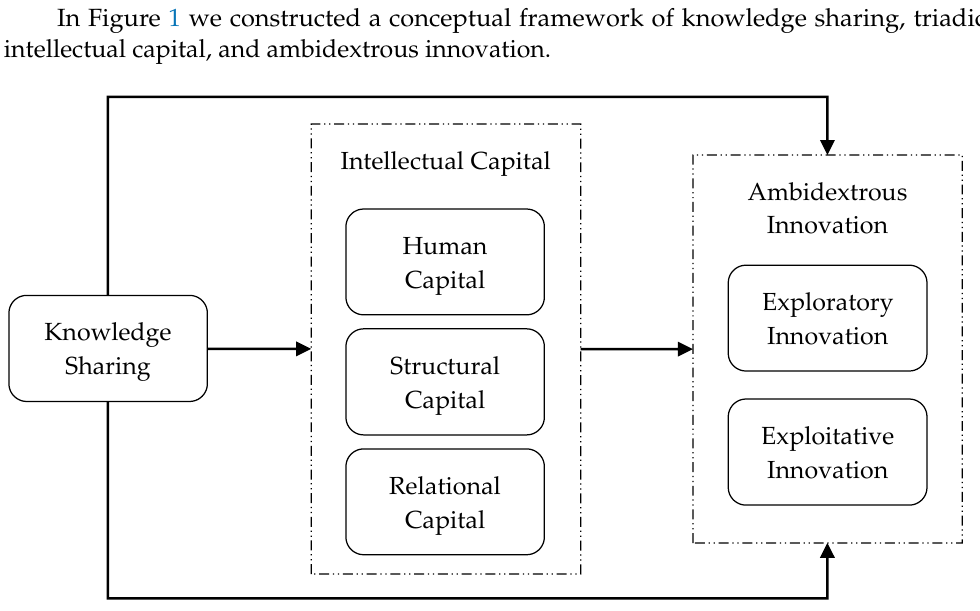
Figure 1. Conceptual framework.